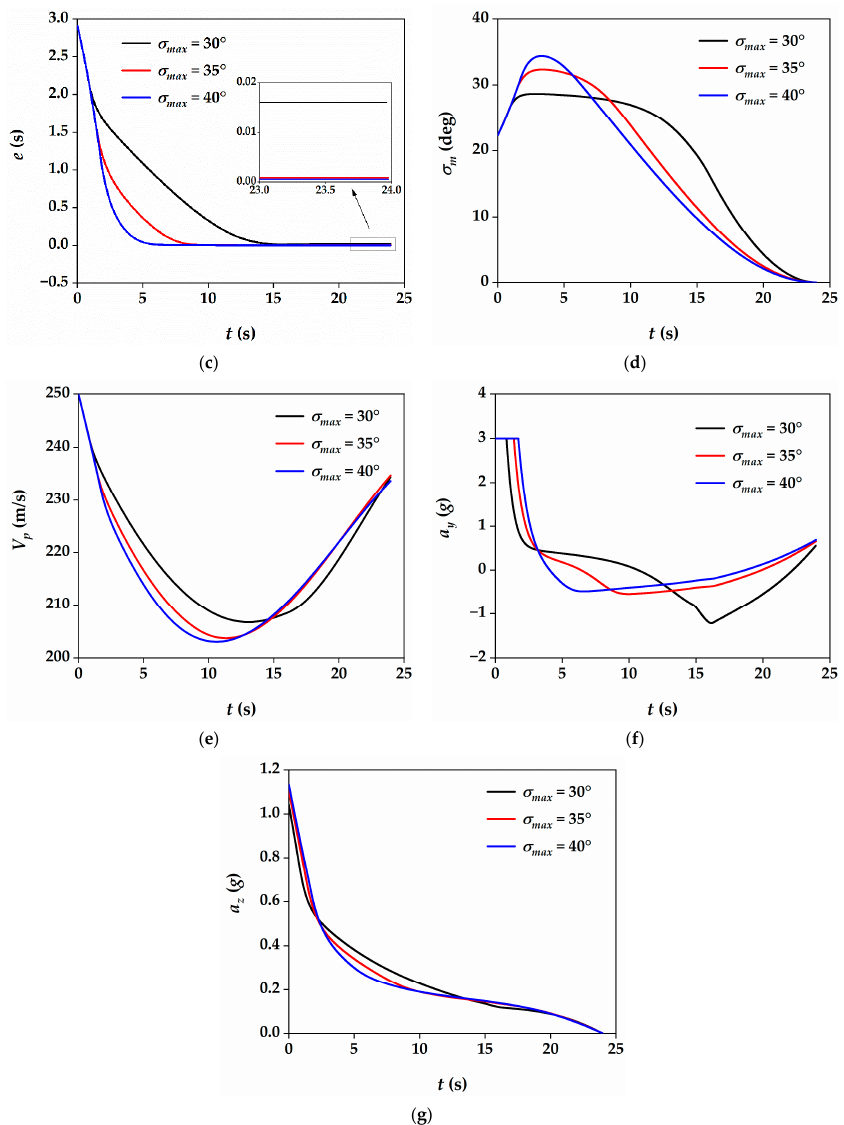
Figure 5. Simulation results under different FOV constraints. ( a ) Projectile flight trajectory; ( b ) relative distance; ( c ) impact time error; ( d ) lead angle; ( e ) velocity; ( f ) normal acceleration; ( g ) lateral acceleration.